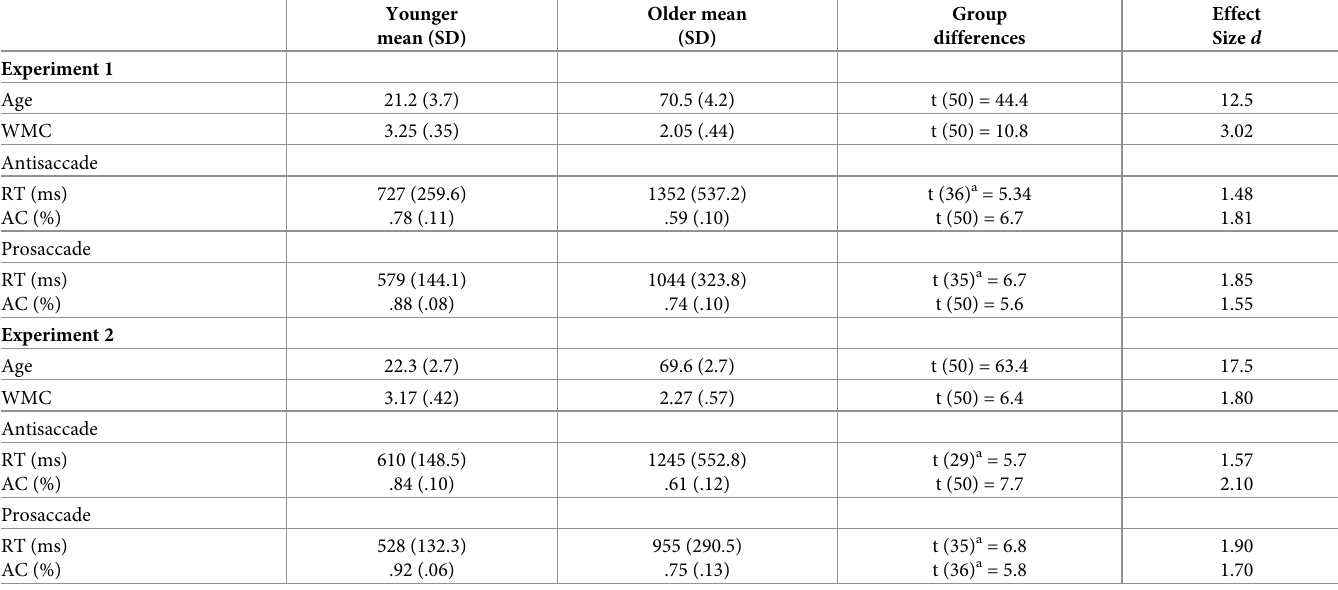
Table 2. Comparisons between younger and older adults in Experiments 1 and